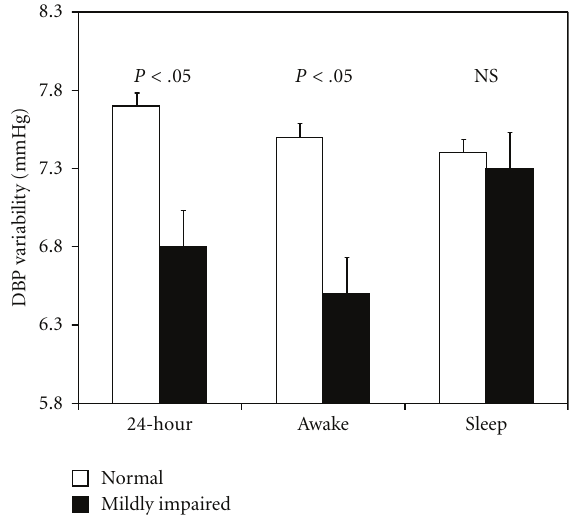
Figure 1: Renal function group di ff erences in DBP variability for awake, sleep, and 24-hour